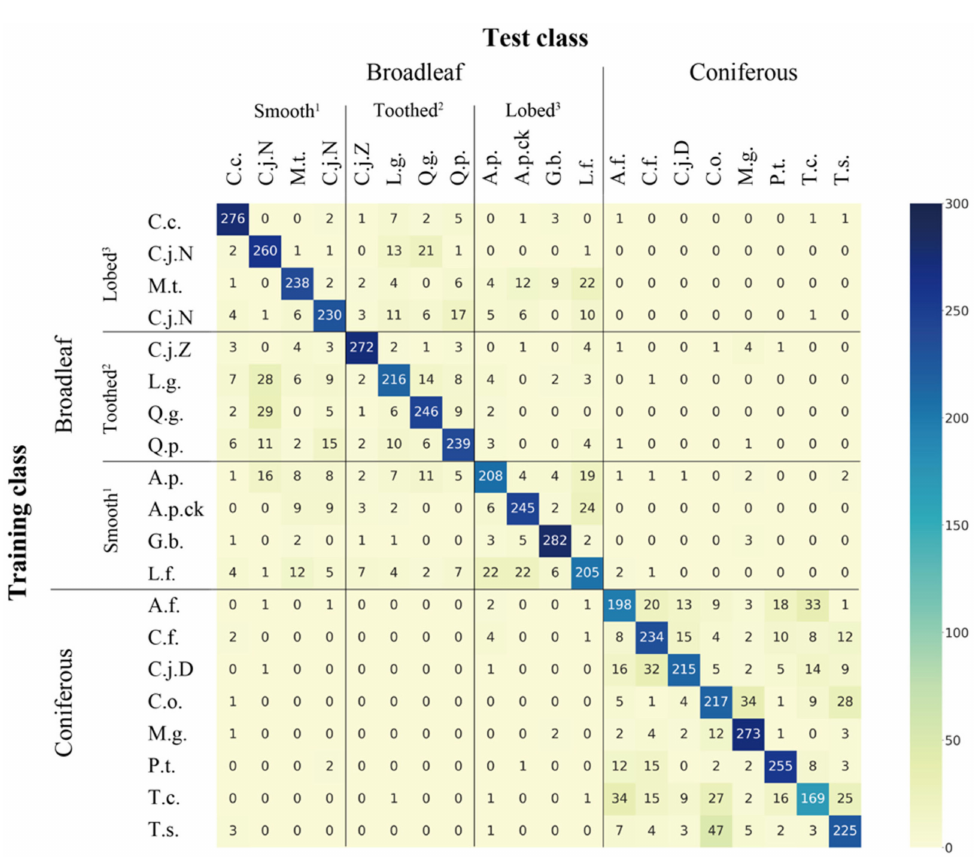
Figure 4. Misclassification patterns according to tree species in AlexNet after 50 epochs without data augmentation. 1 Simple leaves with smooth margins, 2 Simple leaves with toothed margins, 3 Lobed